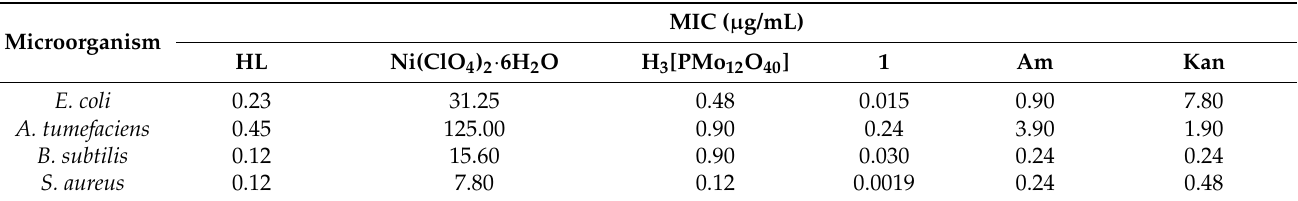
Table 1. In vitro antibacterial activity of 1